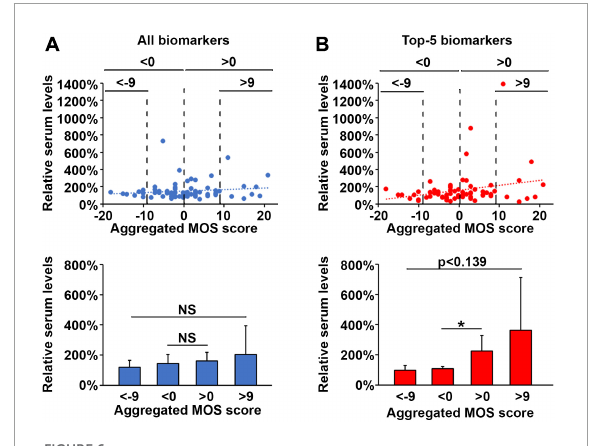
FIGURE6 An increase in pro-inflammatory biomarkers is associated with loss of sleep quality during oncological treatment. Normalized changes in plasma levels of all 17 selected cytokines (A) or pro-inflammatory cytokines (B) with values lower than 100% indicating a reduction in cytokine levels at follow-up compared to baseline and plotted against changes in aggregated MOS scores with negative values indicating improved sleep quality whereas positive values indicate deteriorated sleep quality at follow-up compared to baseline. The lower histographs show the average normalized values for these cytokines among patients with very good sleep (aggregated MOS score < 20), good sleep (aggregated MOS score < 24), poor sleep (aggregated MOS score > 25), and very poor sleep (aggregated MOS score > 31). N = 71. * p < 0.05, NS,